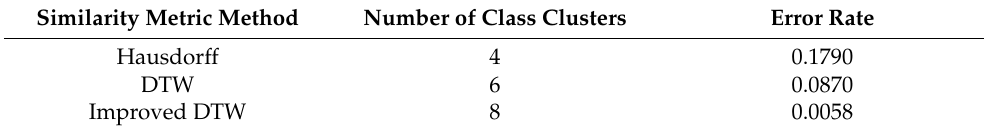
Table 6. DBSCAN clustering results of different trajectory similarity measurement